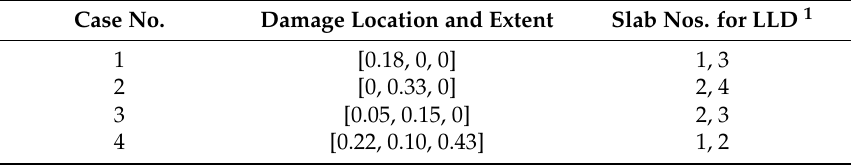
Table 3. Hinge joint damage cases for simply supported bridge with four slabs.